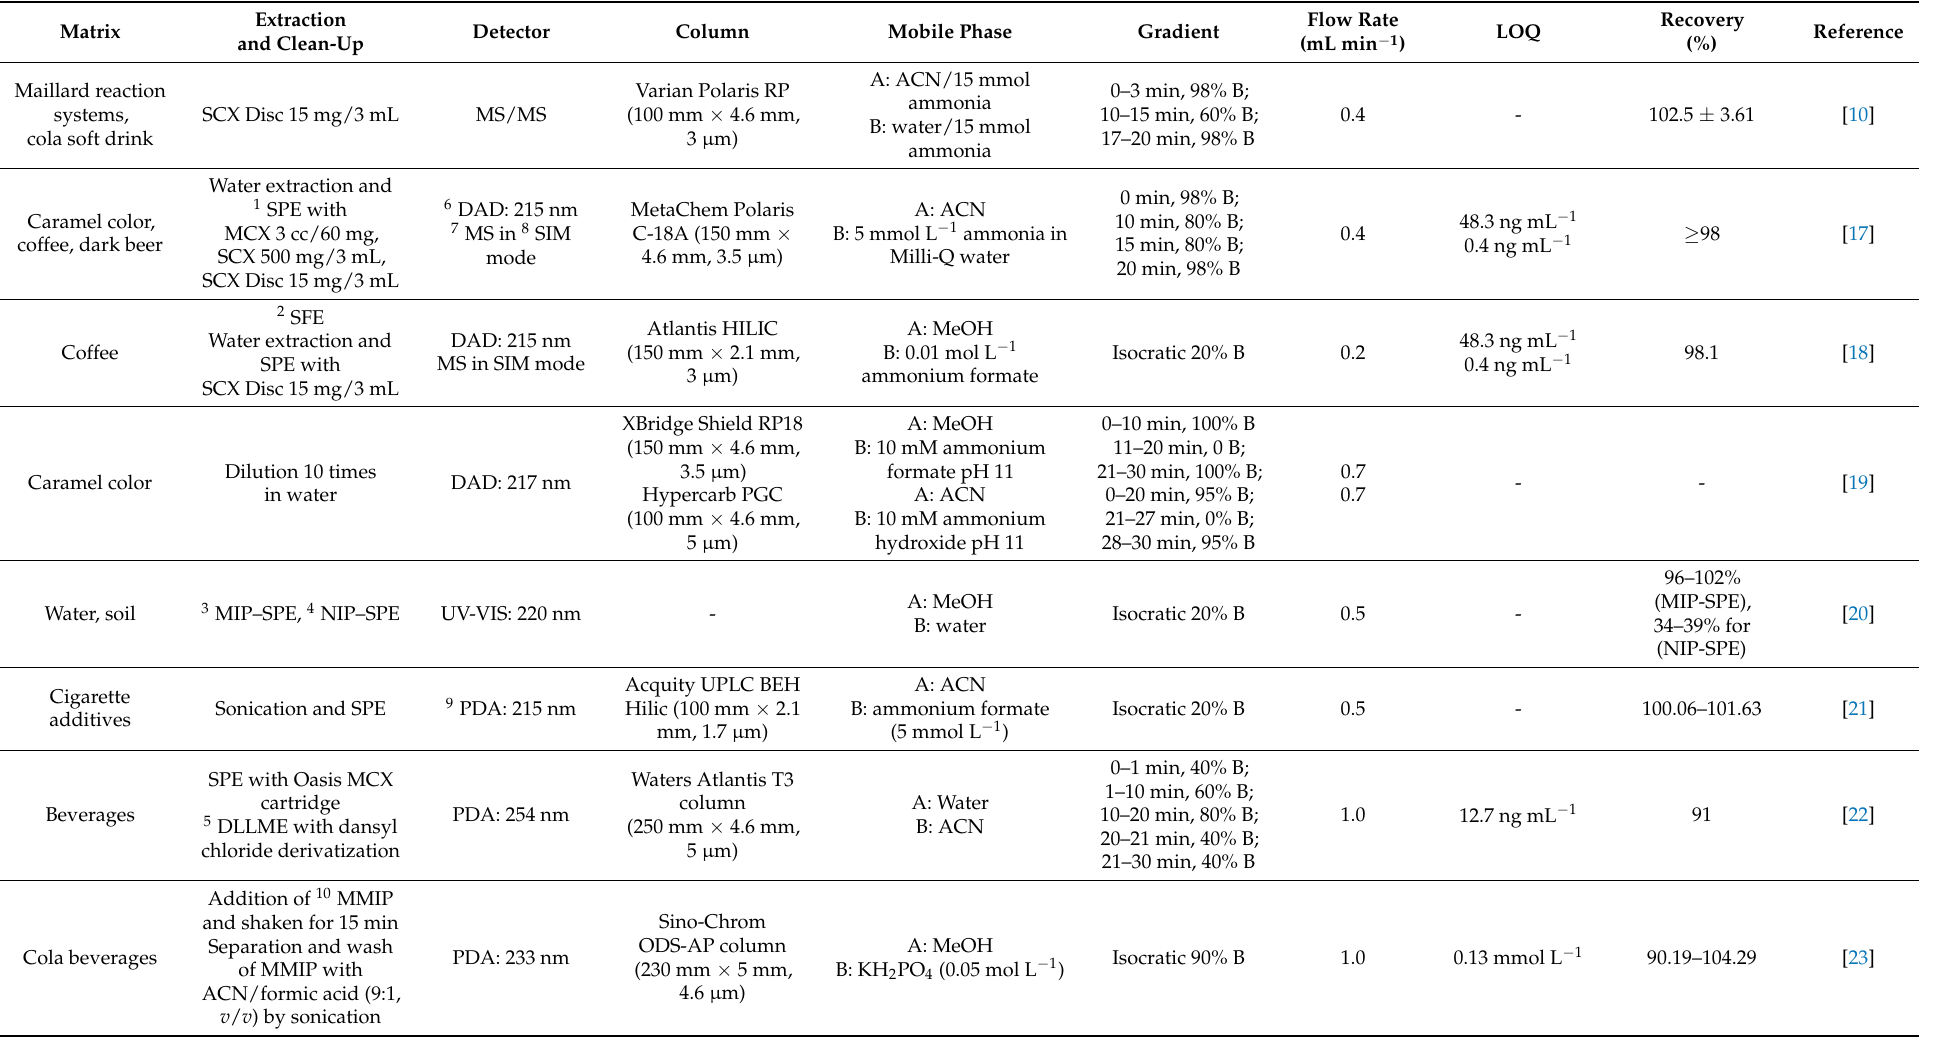
Table 2. Liquid chromatography extraction methods and analysis of 4(5)-methylimidazole in food